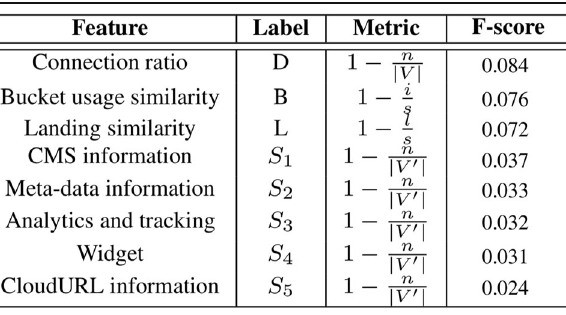
Table 3 F-score of